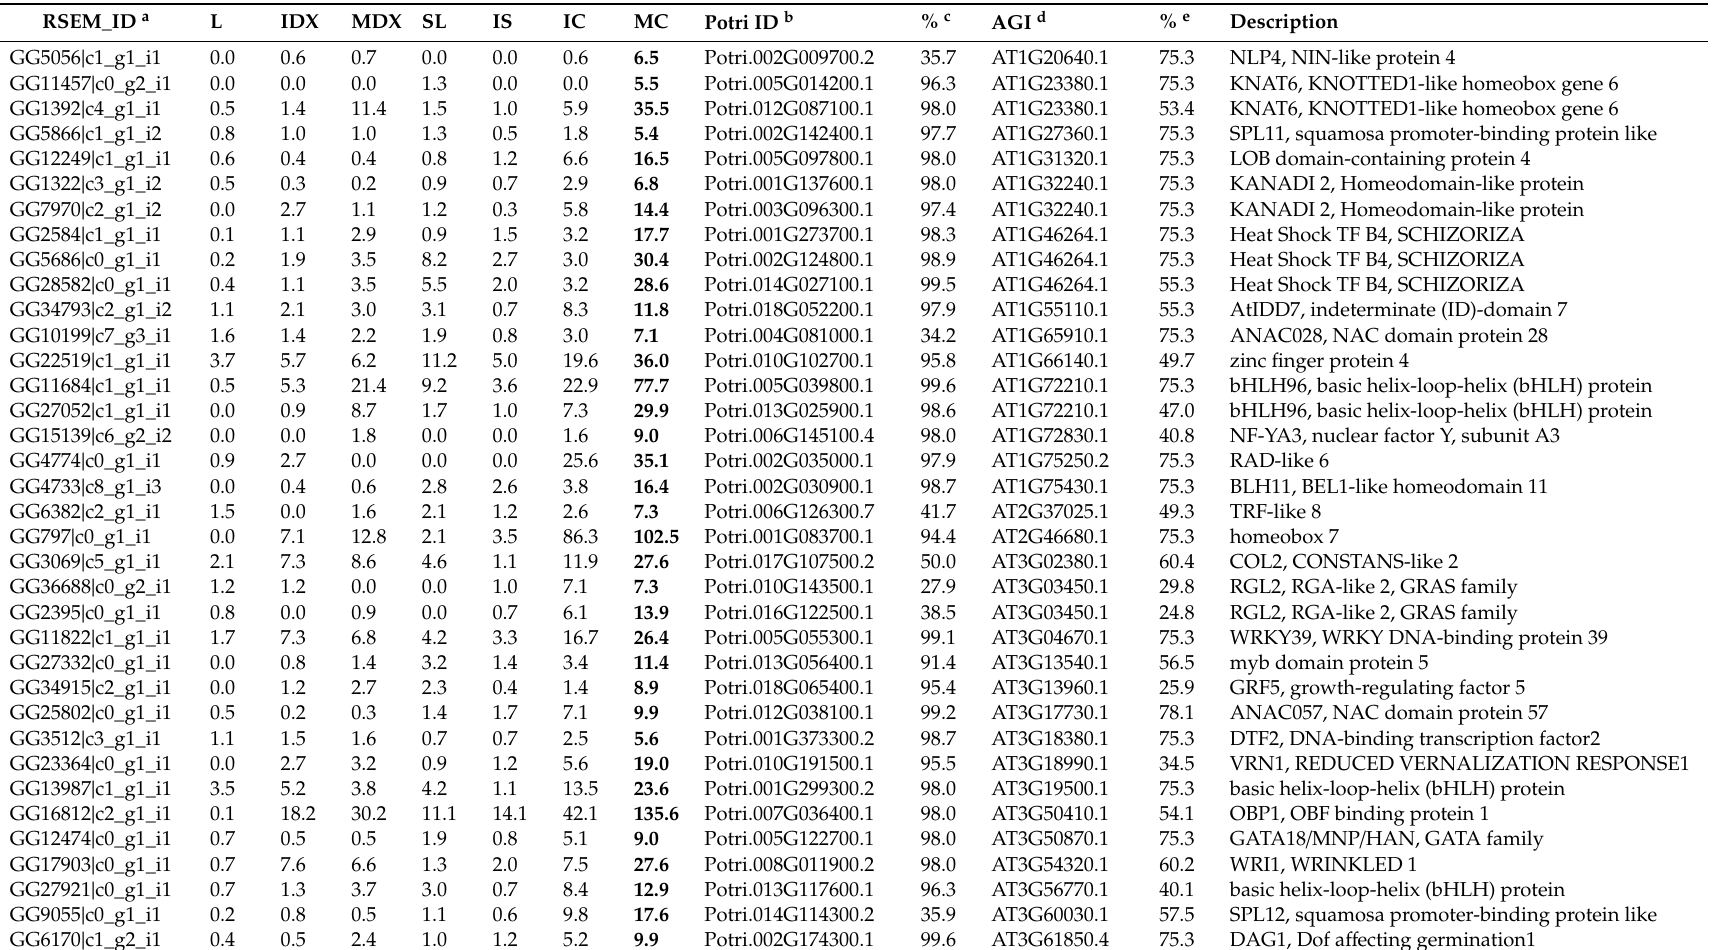
Table 3. Transcriptional regulators preferentially expressed in the mature cambium (MC)